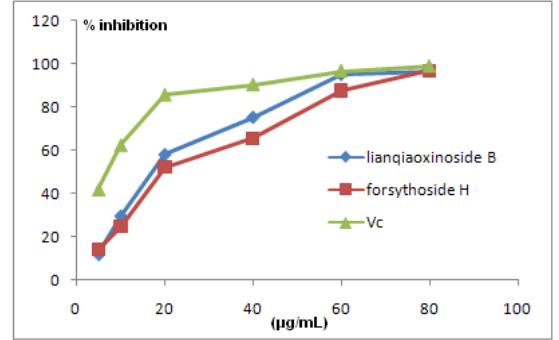
Figure 3. Scavenging effects of samples on ABTS